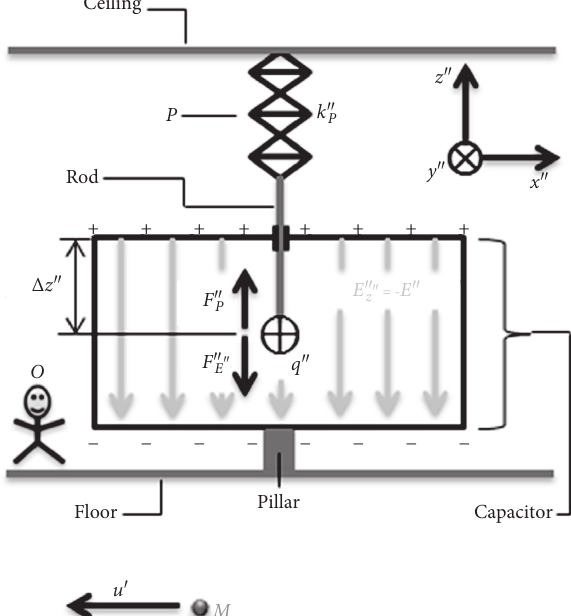
Figure 5: The spring P is attached to a thin, frictionless rod, which has pierced the upper plate of a parallel-plate capacitor. Since the ″ , the tiny charge spring force of F P ″ cancels out the field force of F E ″ q ″ , which is attached to the lower end of the rod, is suspended statically from the standpoint of the lab observer O . Both the rod and the pillar are made of nonconductive materials. On the other hand, because the spring is supposed to be located far outside the capacitor, no EM field affects it. Observer M moves at u ′ along − x ″ as viewed by O